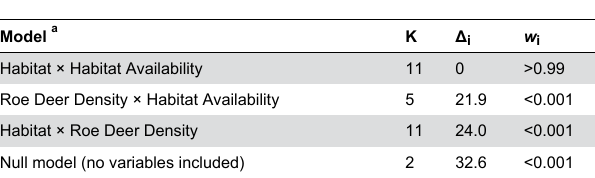
Included in the table are differences in AIC C values between each model and the best model (Δ i ), number of model parameters (K), and model weights ( w i ). We used variation around the grand mean as our null model of no effect of either of the examined variables. Models that included re-colonization by lynx explained variation in habitat selection by roe deer 31-46 AIC C units worse than the top model {Habitat × Habitat Availability} and accounted for <0.001% of the cumulative model